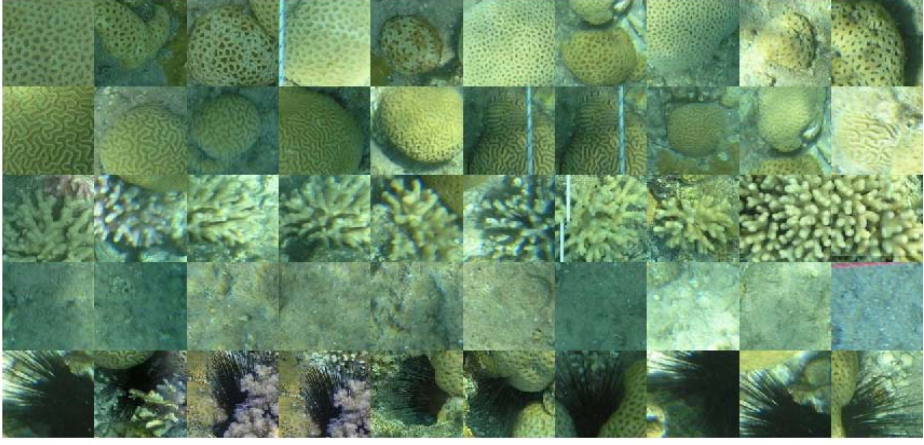
Figure A6. A subset of the EILAT 2 dataset showing 10 examples, in columns, of each of the five classes (in rows from top to bottom: favid coral, brain coral, branching coral, sand and